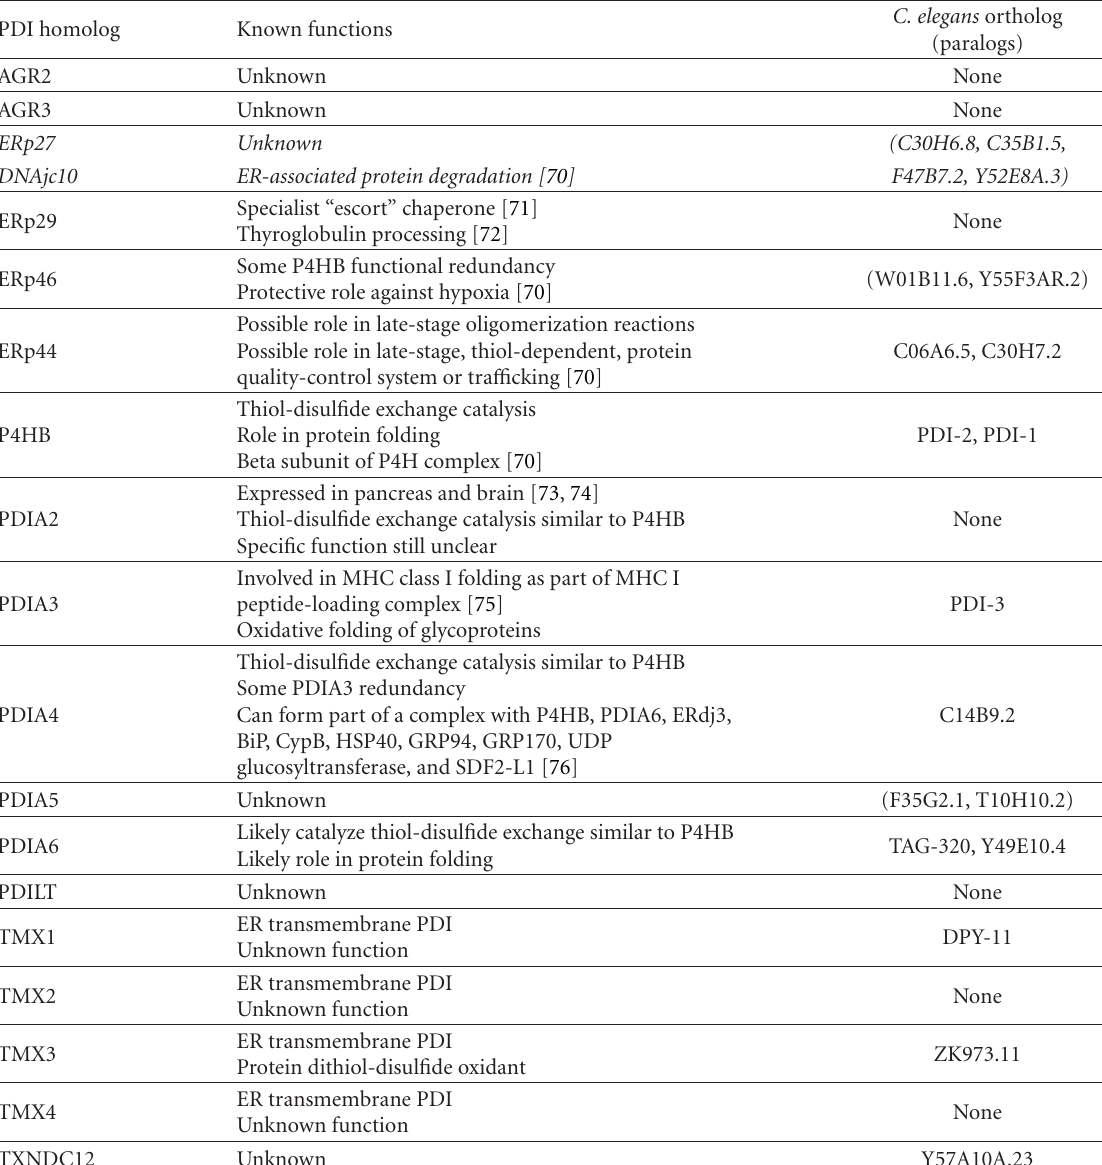
Table 3: Characterised protein disulfide isomerase and their C. elegans